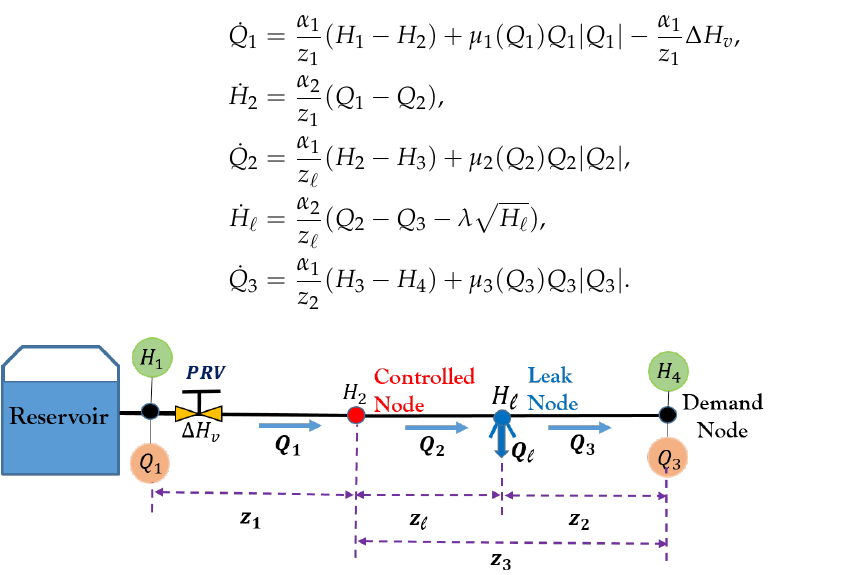
Figure 3. Case 2: Pipeline with a leak after the controlled